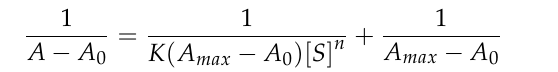
Figure 5. Absorption spectra of tetracaine hydrochloride in the presence of increased concentrations of ( a ) TCH + SDS and ( b ) TCH + SLS.